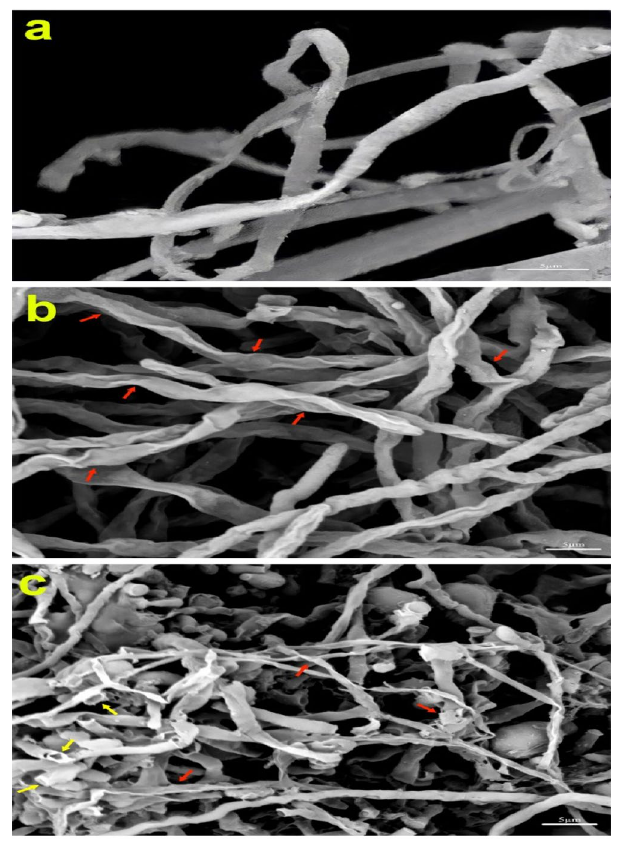
Figure 3. Scanning electron microscopy of T. rubrum morphologies. Images represent the cells in non-treated ( a ) and CAP-treated samples ( b and c ). The untreated sample (control) shows normal tubular and uniform hypha. The cells were treated by CAP irradiation for 210 s and cultured for 24 h (A) and 96 h (B). There is minor deformation in the shape of the cells and break down in cell wall or wrinkle after 24 h of cultivation (red arrows) ( b ), while significant alterations are evident after 96 h incubation ( c ); these are the fragmentation of cells into flat shapes (red arrows), the leakage of intracellular material after perforation (yellow